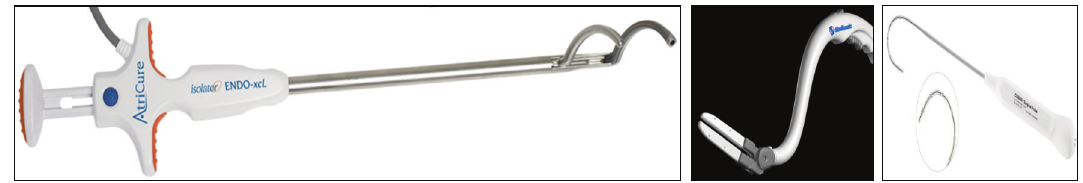
Figure 2: Modern radiofrequency energy ablation devices, Atricure Isolator Synergy TM Ablation Clamp (left), Medtronic Cardioblate TM BP2 (middle), and Estech Cobra TM Surgical Probe (right).